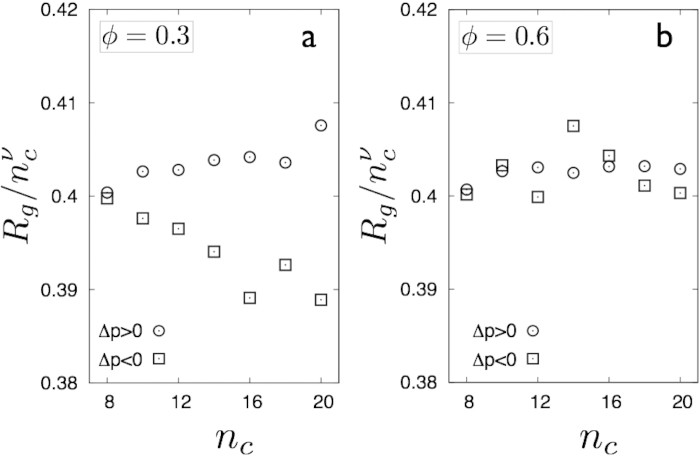
The radius of gyration Rg as a function of the size nc of the droplets where we have factored out the , with ν = 0.64 (branched polymer) dependence. Below the percolation transition, a, the droplets for the  and  branches behave differently assuming string-like (ν ~ 1) and compact (ν ~ 1/2) configurations respectively. Above percolation b, the morphology of droplets changes drastically and all droplets become branched polymers.